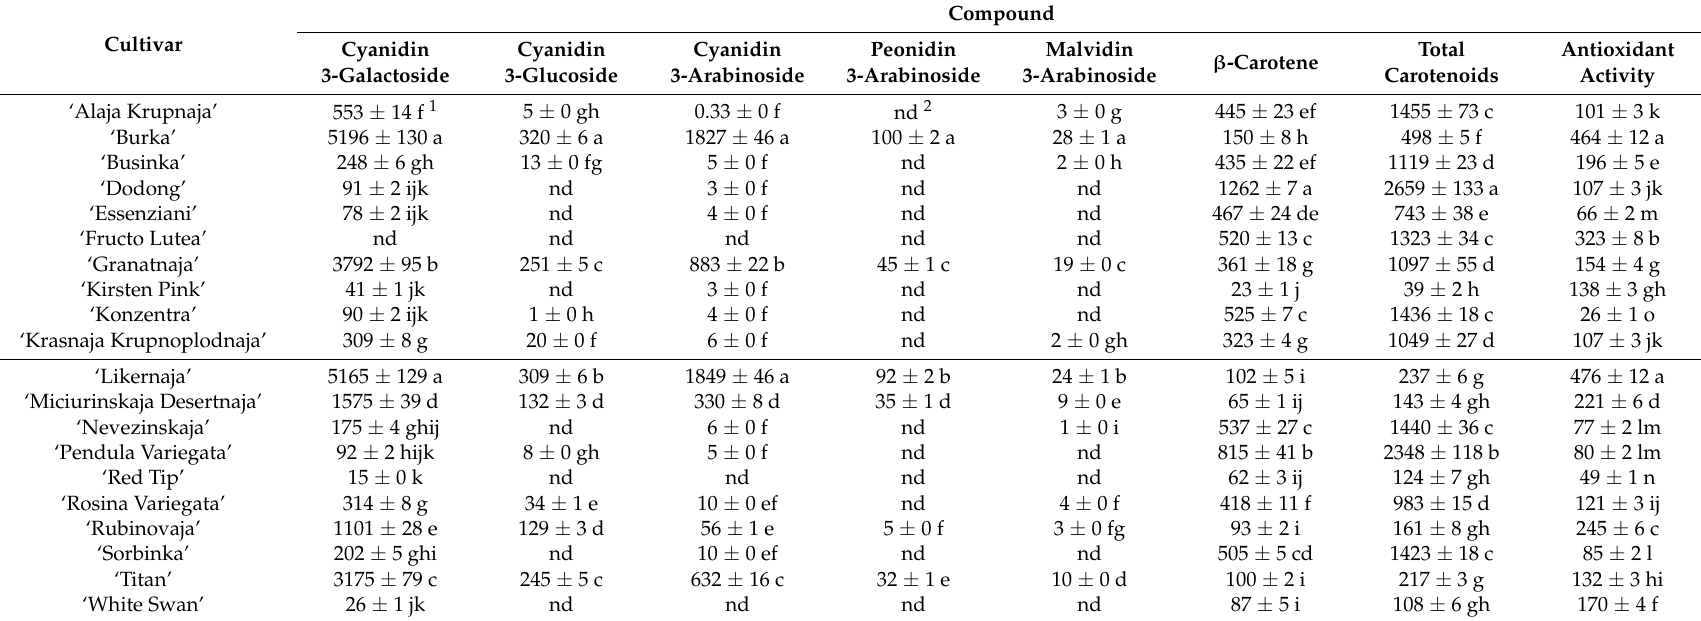
Table 3. Contents of anthocyanins, carotenoids ( µ g/g DW) and antioxidant activity ( µ mol TE/g) of Sorbus fruit powder samples.